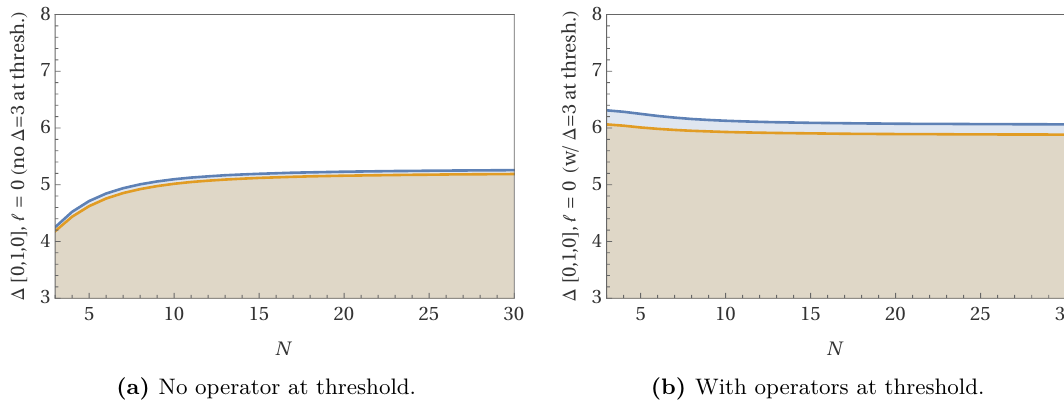
Figure 5. Upper bound for the gap on the dimension of the scalar transforming in the [0 , 1 , 0] as a function of N . The different curves are the different values of Λ = 19 , 23 . The first imposes a gap while the second allows for the presence of an operator sitting at ∆ = 3 . This accounts for possible “dynamically protected” operators as discussed in section